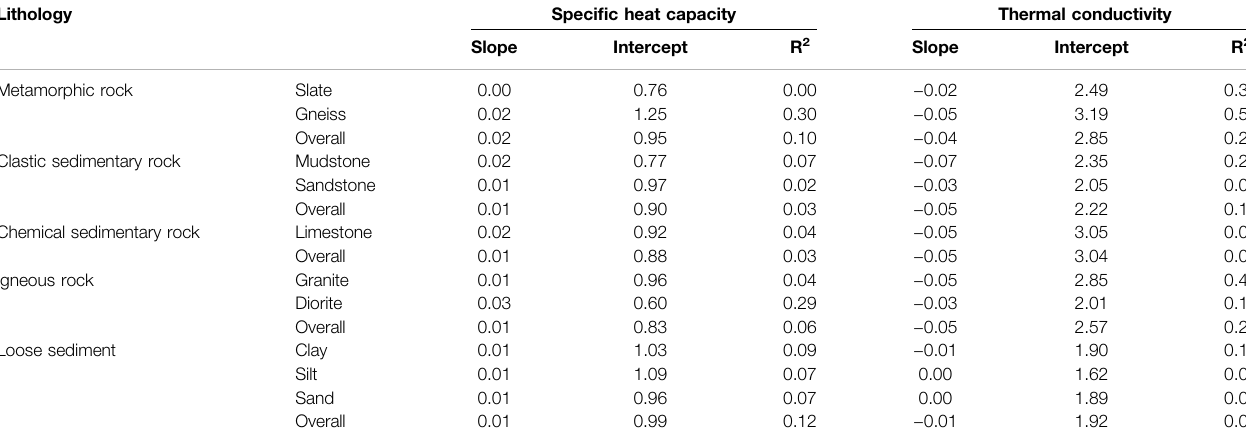
TABLE 4 | Regression analysis results for thermophysical properties and water contents.